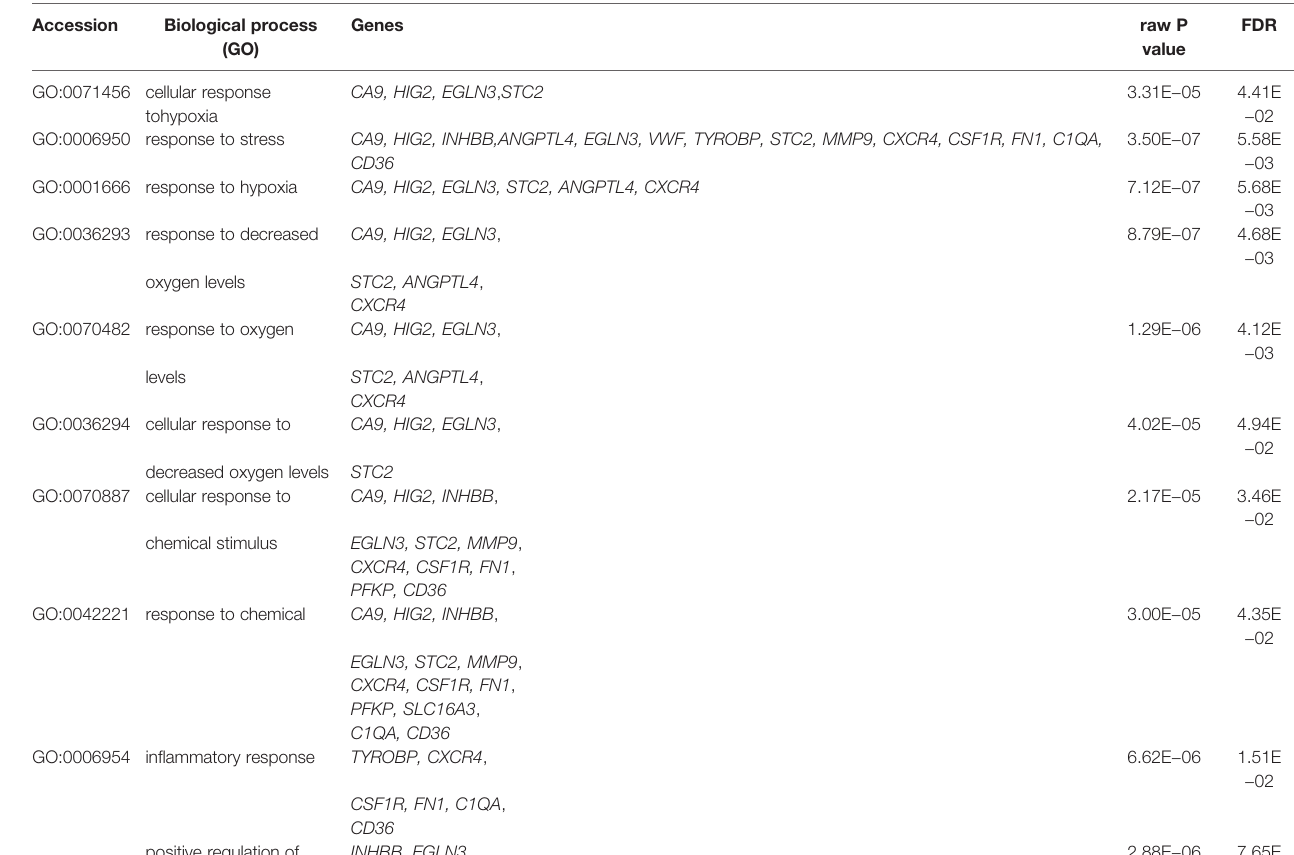
TABLE 4 | The GO processes involving the genes under